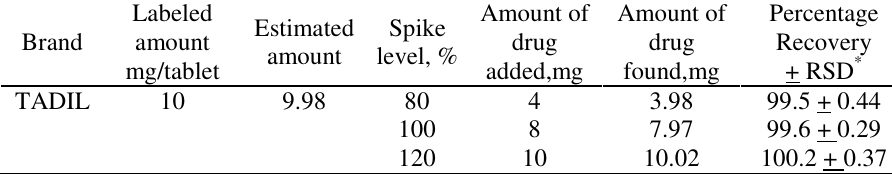
Table 2. Assay of tadalafil in tablet dosage